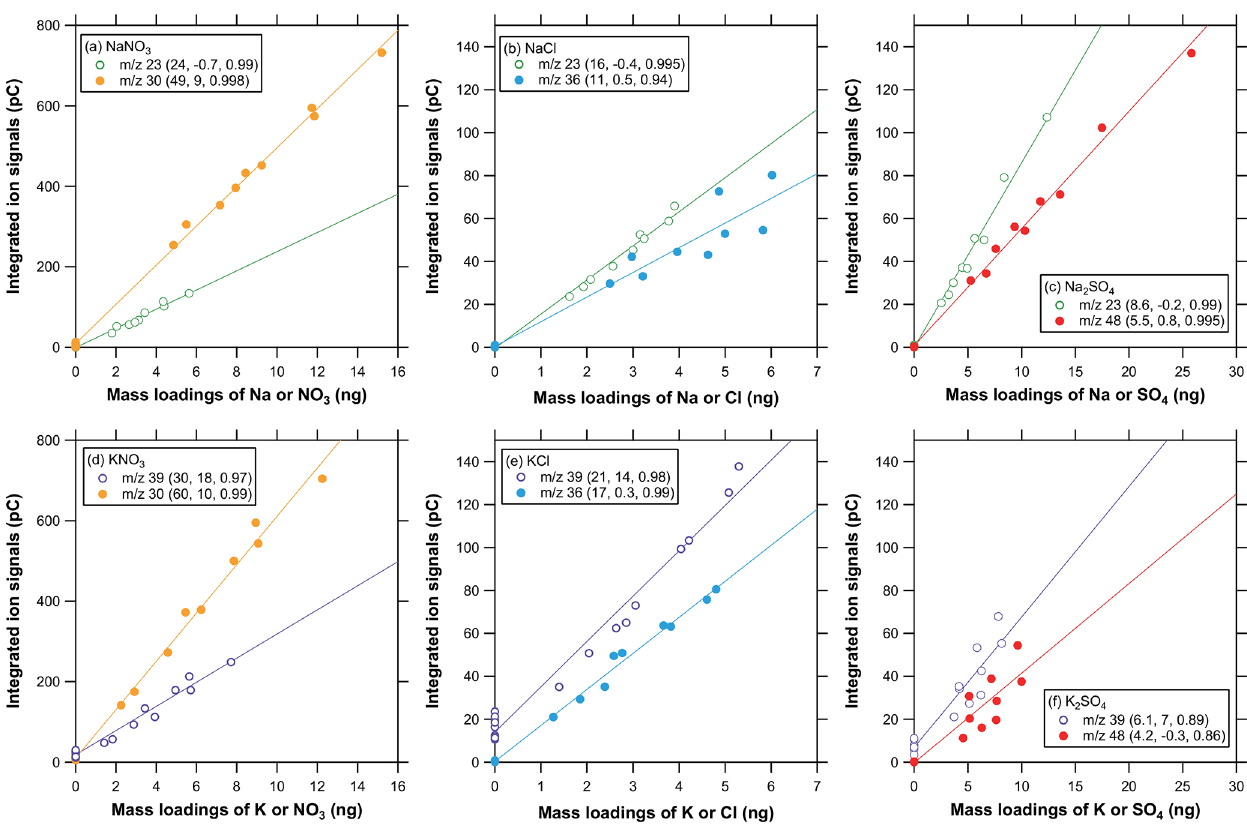
Figure 3. Scatterplots of integrated ion signals versus mass loadings (Na for m/z 23; K for m/z 39; NO 3 for m/z 30; Cl for m/z 36; SO 4 for m/z 48) for (a) SN, (b) SC, (c) SS, (d) PN, (e) PC, and (f) PS particles. The three values in the parentheses in the legend represent the slope, intercept, and r 2 , respectively, for the linear